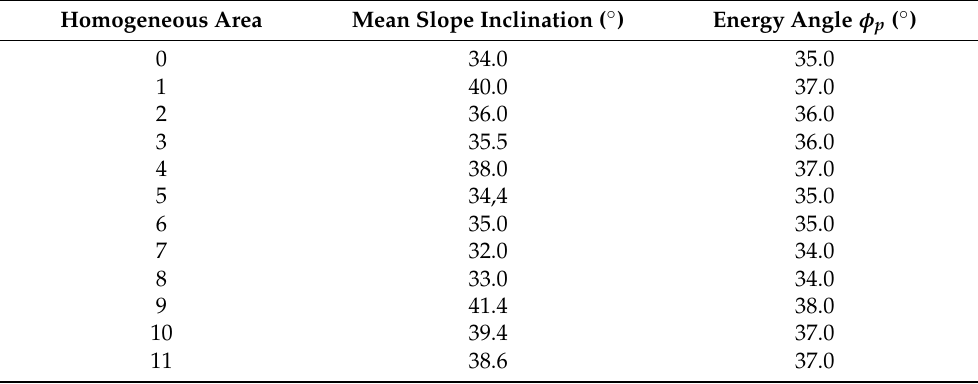
Table 6. Mean slope orientation and energy angle for each homogeneous area, obtained from the chart in Figure 11b, with the assumption of a dense forest coverage and boulder volume V = 1 m 3 .